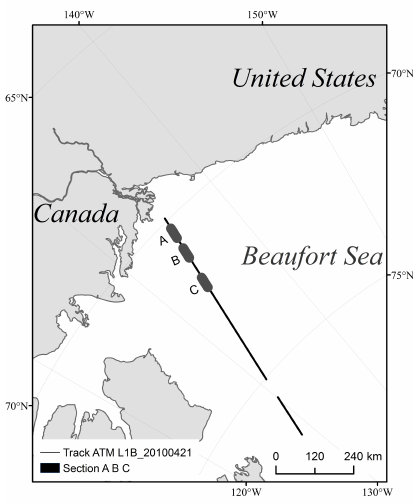
Figure 1. The IceBridge sea ice flight in the Beaufort Sea of Arctic on May 21, 2010 and three selected study sections of A, B and C